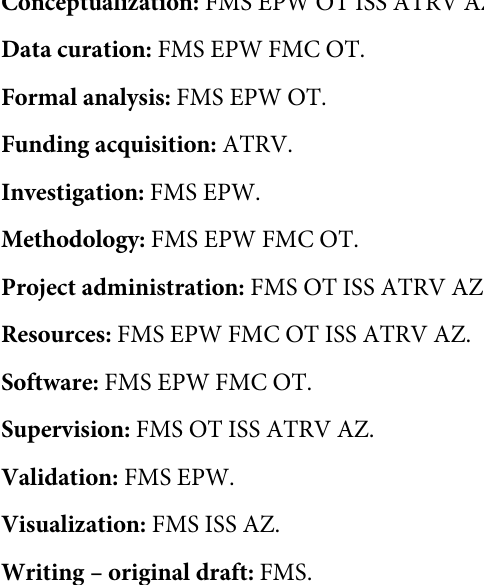
S1 Table. Metagenome from swine lungs with PES and carrier lungs. S2 Table. Mapping coverage per sequence in samples M01 and M02 using the MG-work-